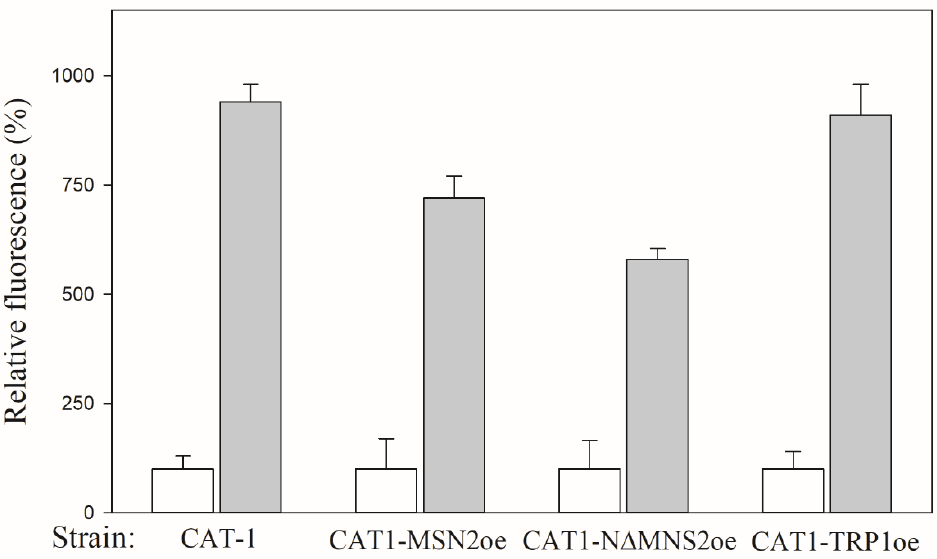
Figure 4. Intracellular oxidation level in strains CAT-1, CAT1-MSN2oe, CAT1-N ∆ MSN2oe, and CAT1-TRP1oe in the presence of ethanol. The fluorescence intensity due to the presence of ROS in the strains was determined before (white bars) and after 6 h of exposure to 20% ethanol (grey bars).